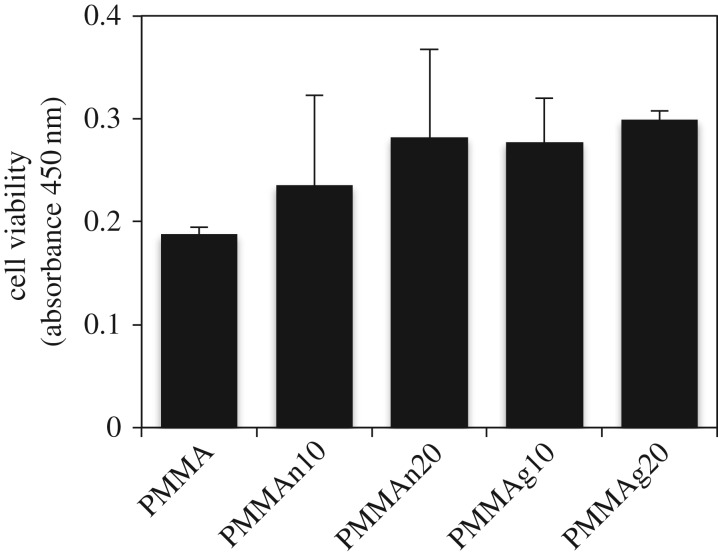
Cell viability of MT3T3-E1 cells on PMMA-based composites. 1 × 104 MT3T3-E1 cells were seeded in each well on 12-well culture plate as control or on tablets. The tablets are PMMA only or PMMA-based composites blended with 10 wt.% and 20 wt.% nHAP or gHAP. After incubation for 1 day, CCK-8 was used to evaluate the cell viability. Error bars show standard deviation.